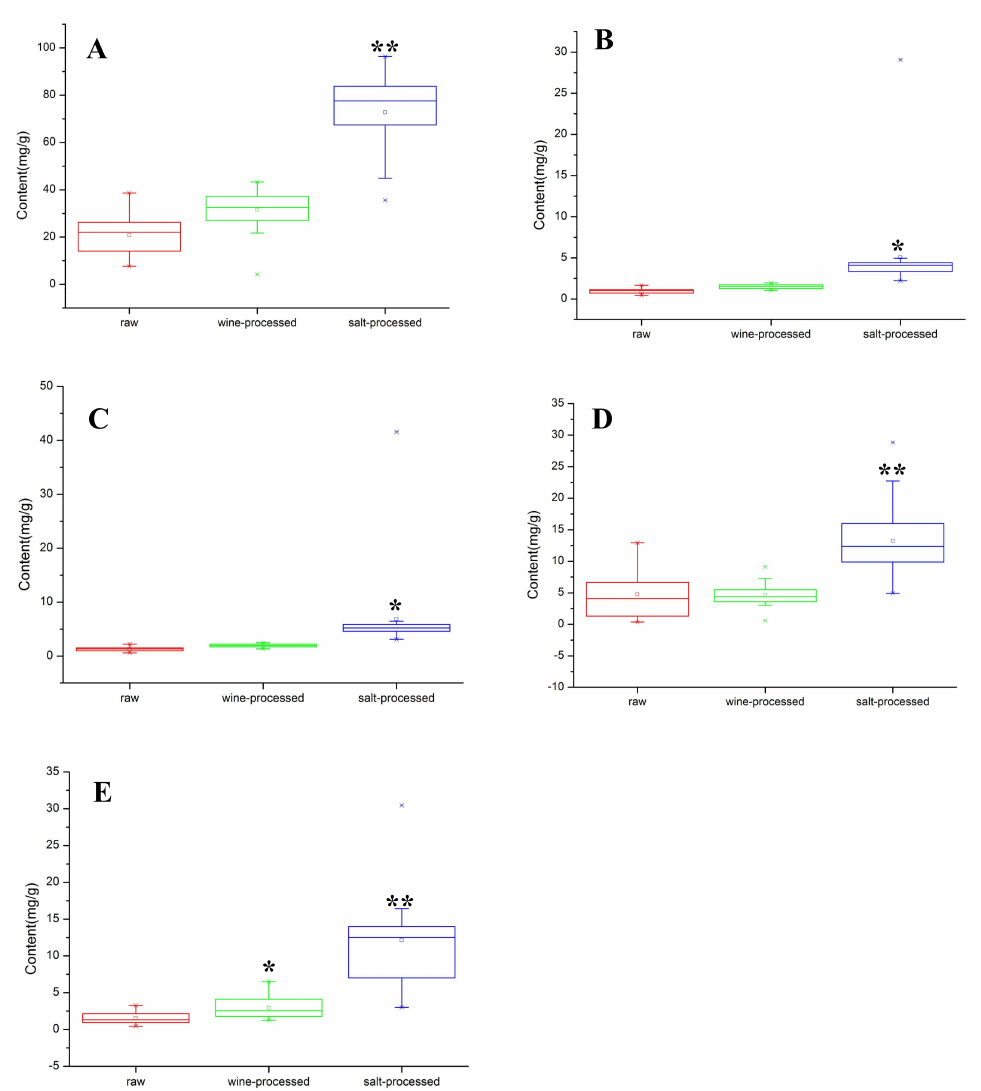
Figure 3. Boxplots of the five target analytes of 21 batches in raw, wine-processed, and salt-processed samples RAB. The A – E in the figure represents the five major analytes in raw, wine-processed, and salt-processed RAB, including: β -ecdysterone ( A ); 25-S inokosterone ( B ); 25-R inokosterone ( C ); ginsenoside R 0 ( D ); and chikusetsusaponin IVa ( E ). Compared with raw samples, * p < 0.05, ** p < 0.01; the middle line in the boxplot represents the